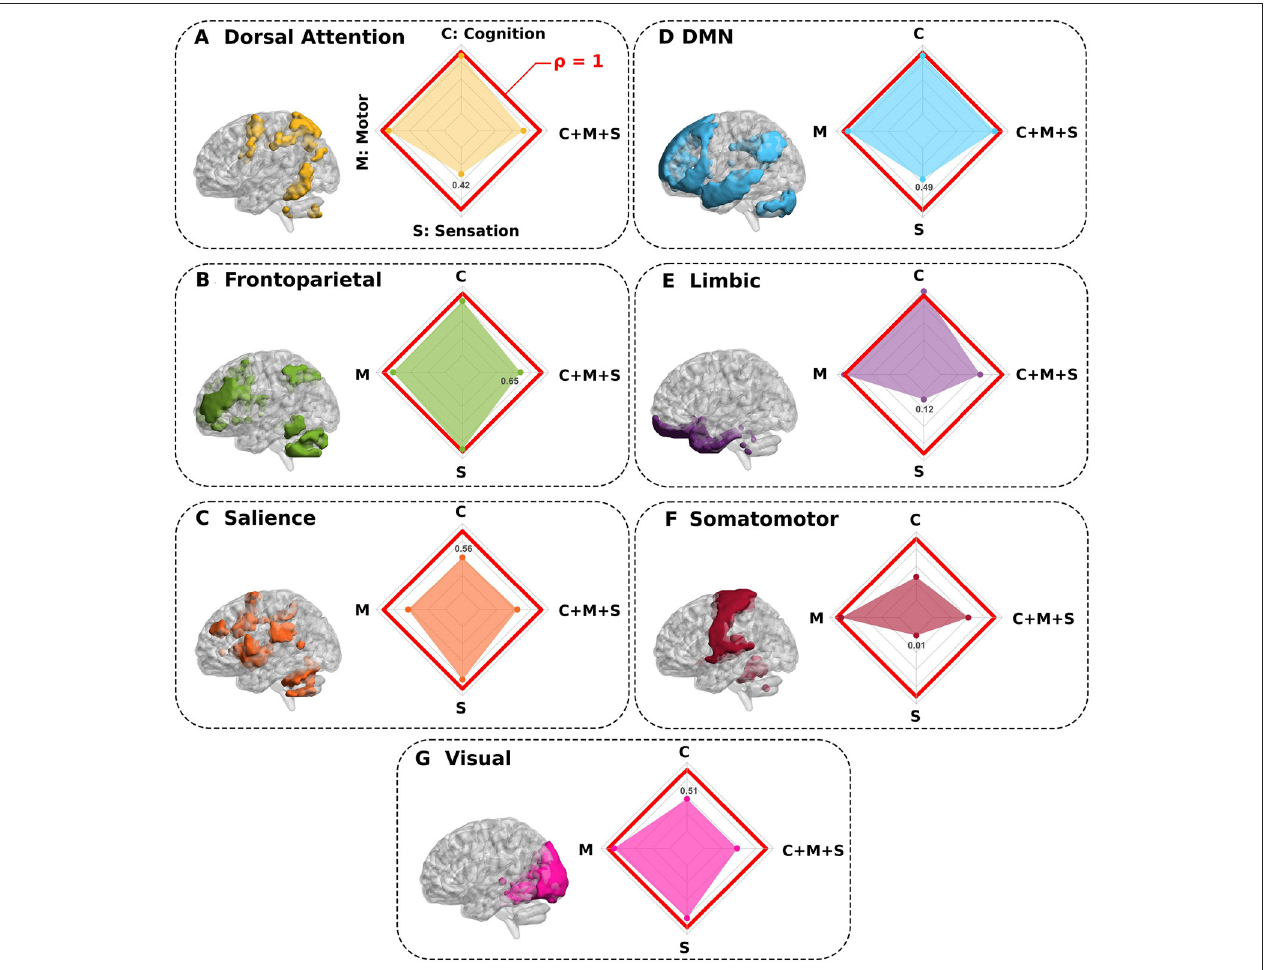
FIGURE 4 | Synthetic complete deletions of functional resting state networks and their impact in predicting neuro-behavioral scores. (A–G) Seven different functional networks were completely deleted (separately one by one) to quantify the impact that each specific network has in predicting behavior. In particular, after a network deletion, we recalculated new connectivity matrices in its absence and re-calculated the association with behavior for this novel situation. All panels show the network deleted and the performance ratio ρ between the synthetic deletion as compared to the situation where all regions were present (spider plot). While values of ρ close to 1 (red line in the spider plot) show regions such that their deletions do not greatly impact the behavior prediction, values smaller than 1 show the networks that had the highest contribution in predicting behavior (for each spider plot, the minimum value is